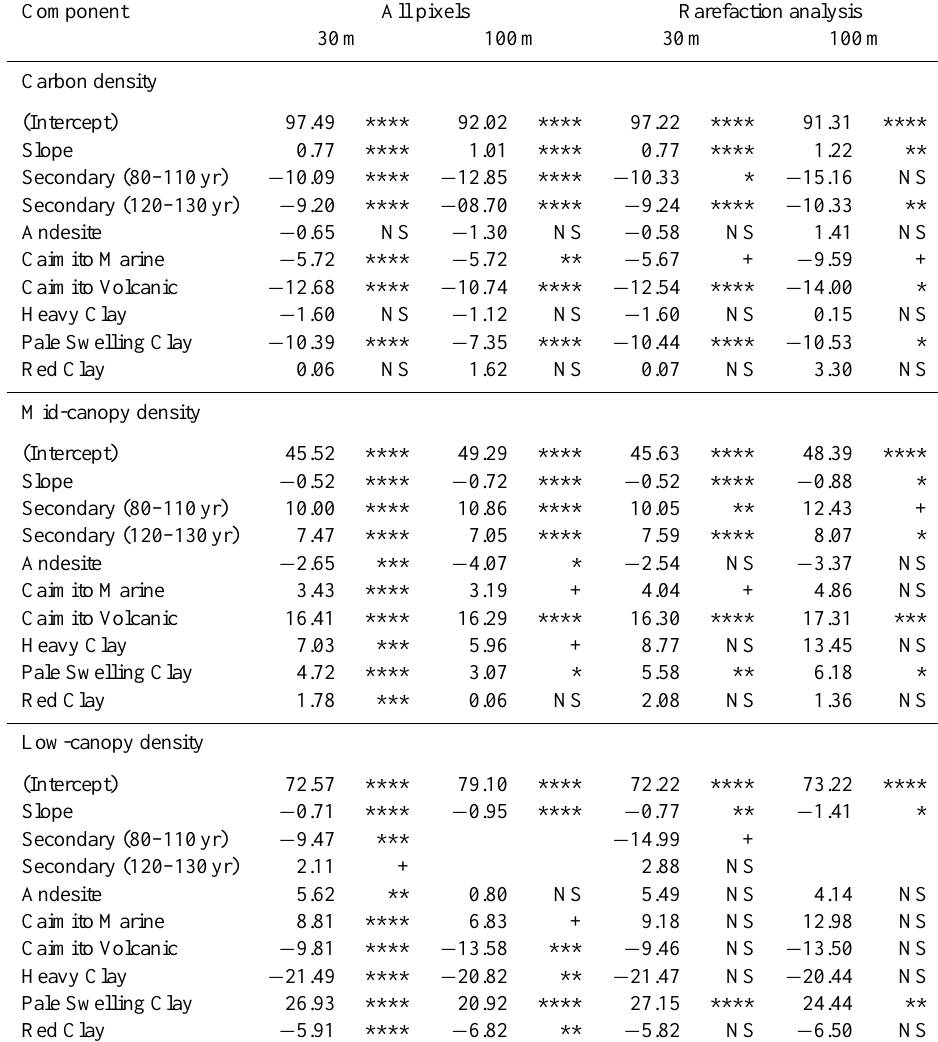
Table 4. Fitted coefficients of multiple regression analysis of variables controlling carbon density variation on BCI, Panama. With the exception of slope, all variables are categorical and thus coefficients reflect predicted deviation from the base classes (these are “Old-growth” in forest type, “Bohio” in bedrock type, and “Brown Fine Loam” in soil type). The primary model utilized all areas inside a 50-m shoreline mask on BCI, shown here at two resolutions: 13959 0.09-ha pixels (30m), and 1048 1.0-ha pixels (100m). The rarefaction analysis repeated the model 1000 times using 10% of all pixels at each resolution; for this analysis, median P-values from all runs are